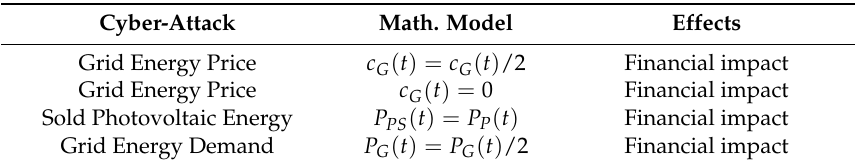
Table 5. Mathematical model for the simulation of confidentiality